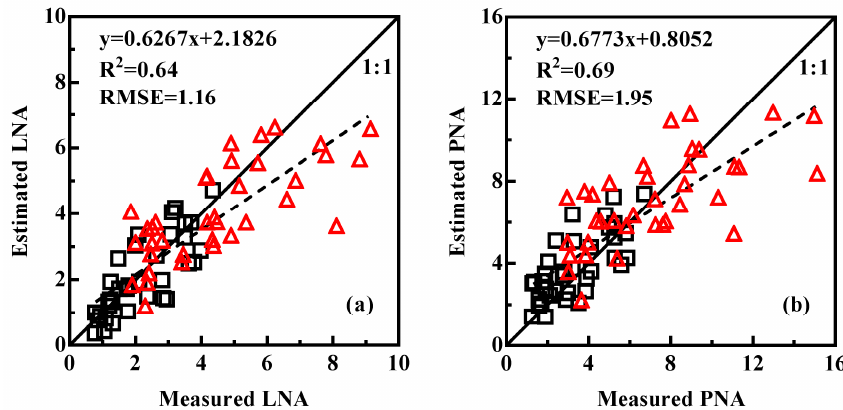
Figure 9. The 1:1 relationship between the estimated and measured leaf N accumulation (LNA, g m − 2 ) and plant N accumulation (PNA, g m − 2 ) in rice based on two-stage (tillering and jointing) model using color indices derived from the RGB images: NGRDI-LNA model ( a ) and NExG-PNA model ( b ). The solid line indicates the 1:1 line and the dashed line indicates the regression line.